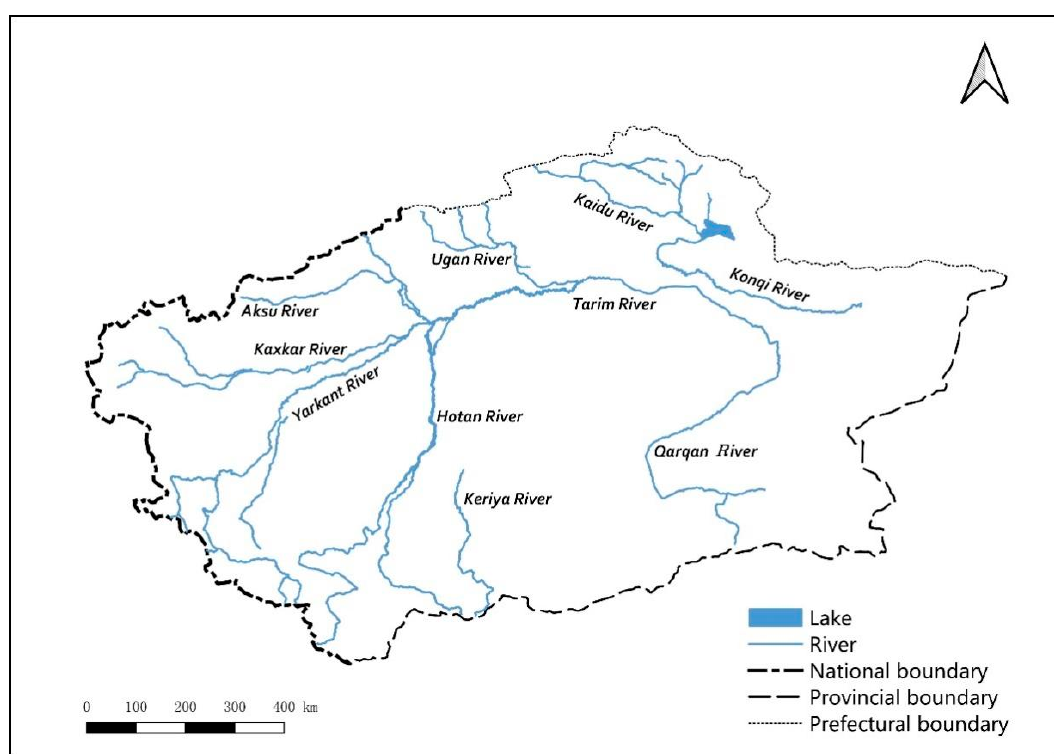
Figure 1. Tarim River Basin, Xingjiang, China.